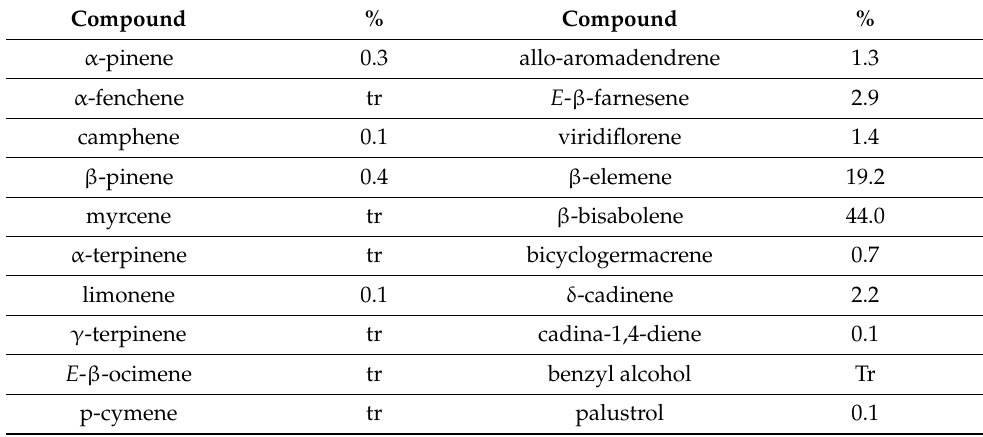
Table 7. Compounds identified in the leaf oil of Backhousia hughesii